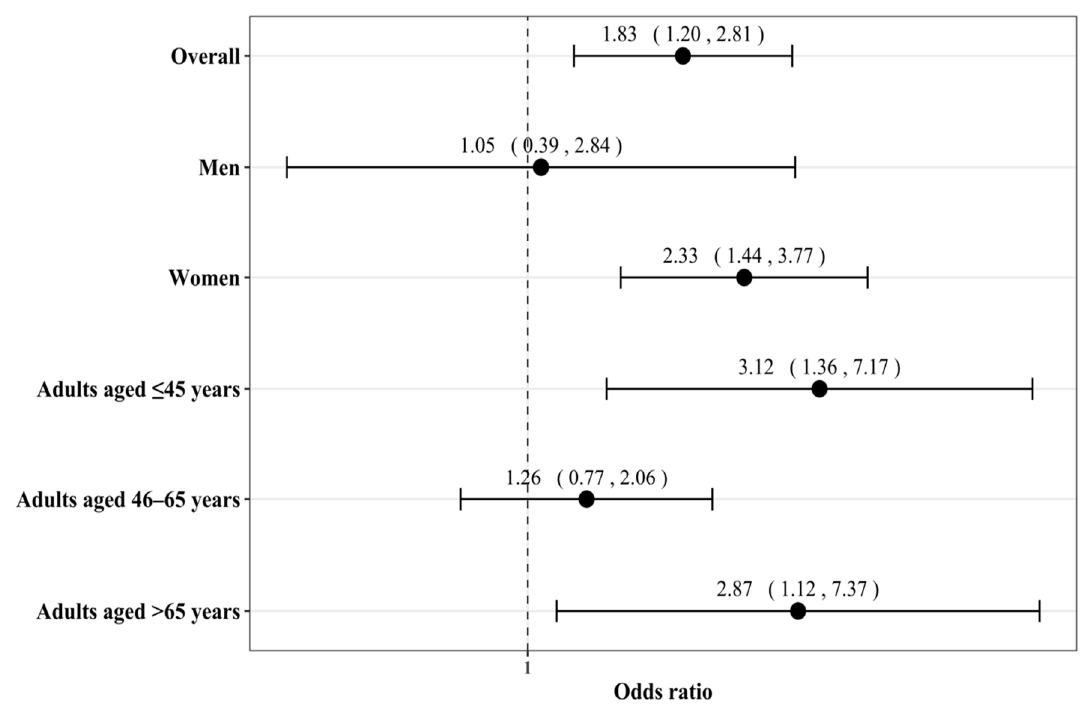
Figure 3. Association between arthritis and migraine in adults living in the US .